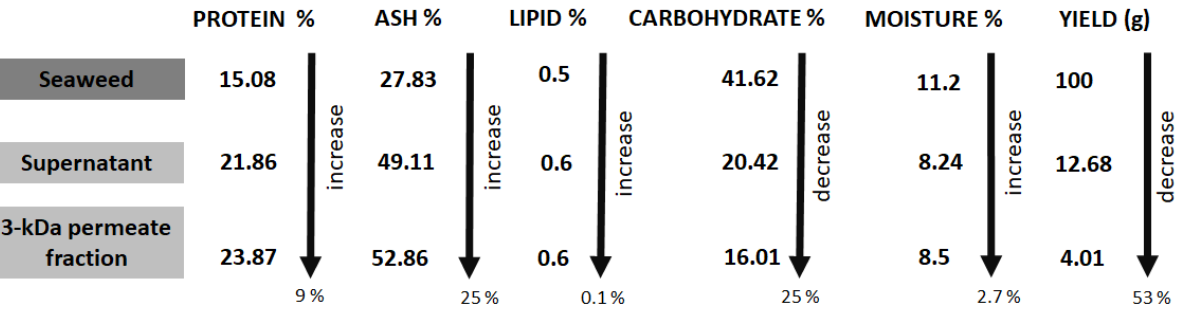
Figure 2. ( a ) L. digitata whole seaweed; ( b ) freeze-dried L. digitata hydrolysates generated using Vis- cozyme and the protease enzyme Alcalase ® and ( c ) the L. digitata permeate fraction generated by filtration with a 3-kDa MWCO filter permeate fraction recovered.